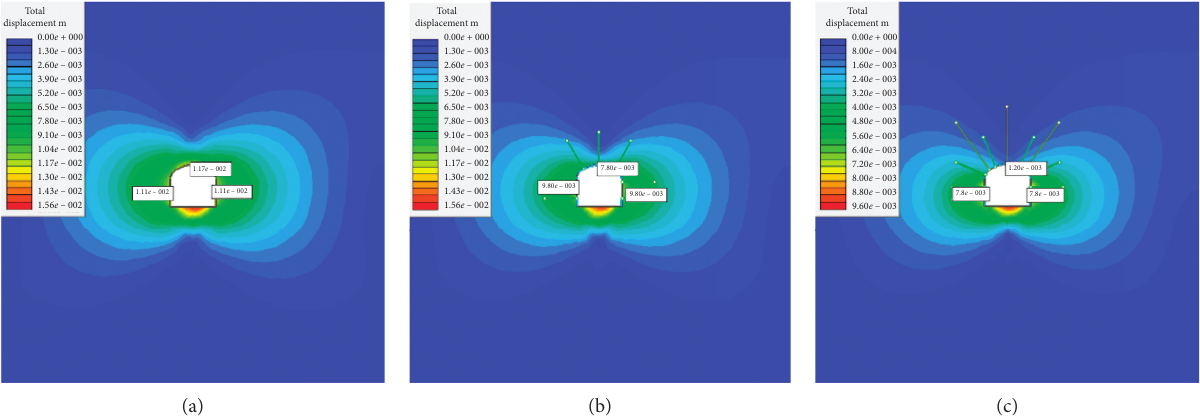
Figure 11: The total displacement surrounding the drift for (a) sophisticated support, (b) support suggested by Q -system, and (c) the combination support system.